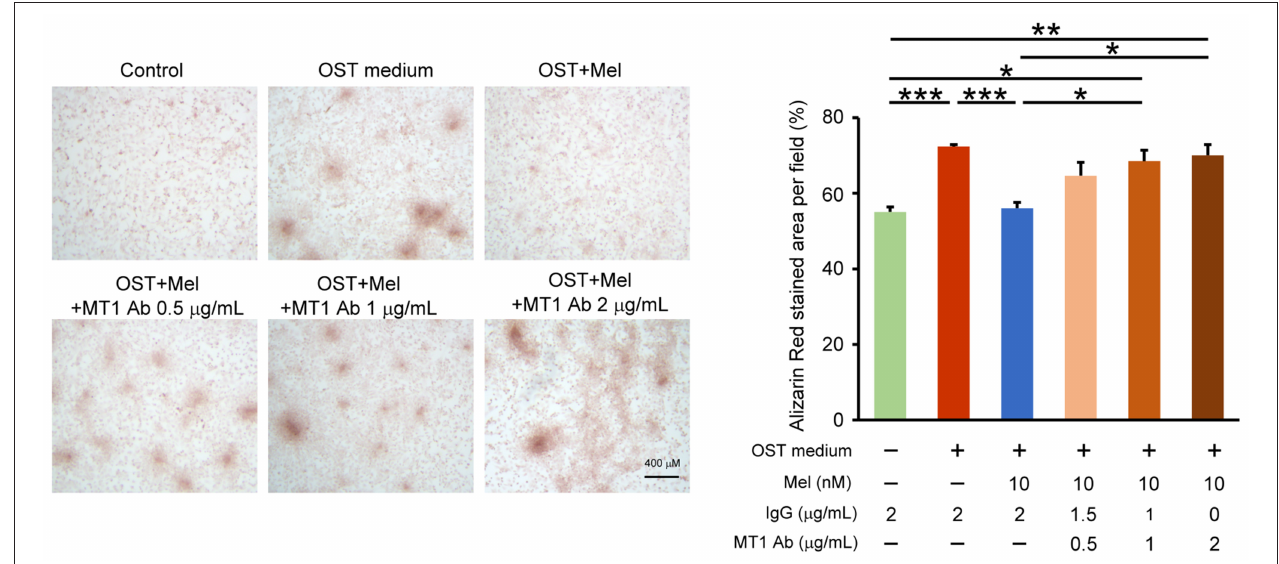
FIGURE 5 | Effect of MT1 neutralized antibody on melatonin-attenuated VIC calcification. The left panel depicts representative Alizarin red S staining of VICs with or without melatonin (10 nmol/L) or with or without MT1 neutralized antibody (MT1 Ab, 0.5, 1 and 2 µ g/mL) or control IgG (0.5, 1 and 2 µ g/mL). We quantified the positive stain area (red color) per field (three fields per treatment) in the VICs ( n = 4). The right panel presents the summary data of the percentage of calcification area ( n = 4). Control (Con) vs OST: P = 0.002; OST vs. OST + Mel 10nM: P = 0.003; OST + Mel 10nM vs. OST + Mel 10nM + MT1 Ab 1 µ g/mL: P = 0.027; Con vs.